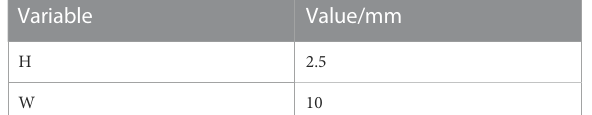
TABLE 1 Computational domain size